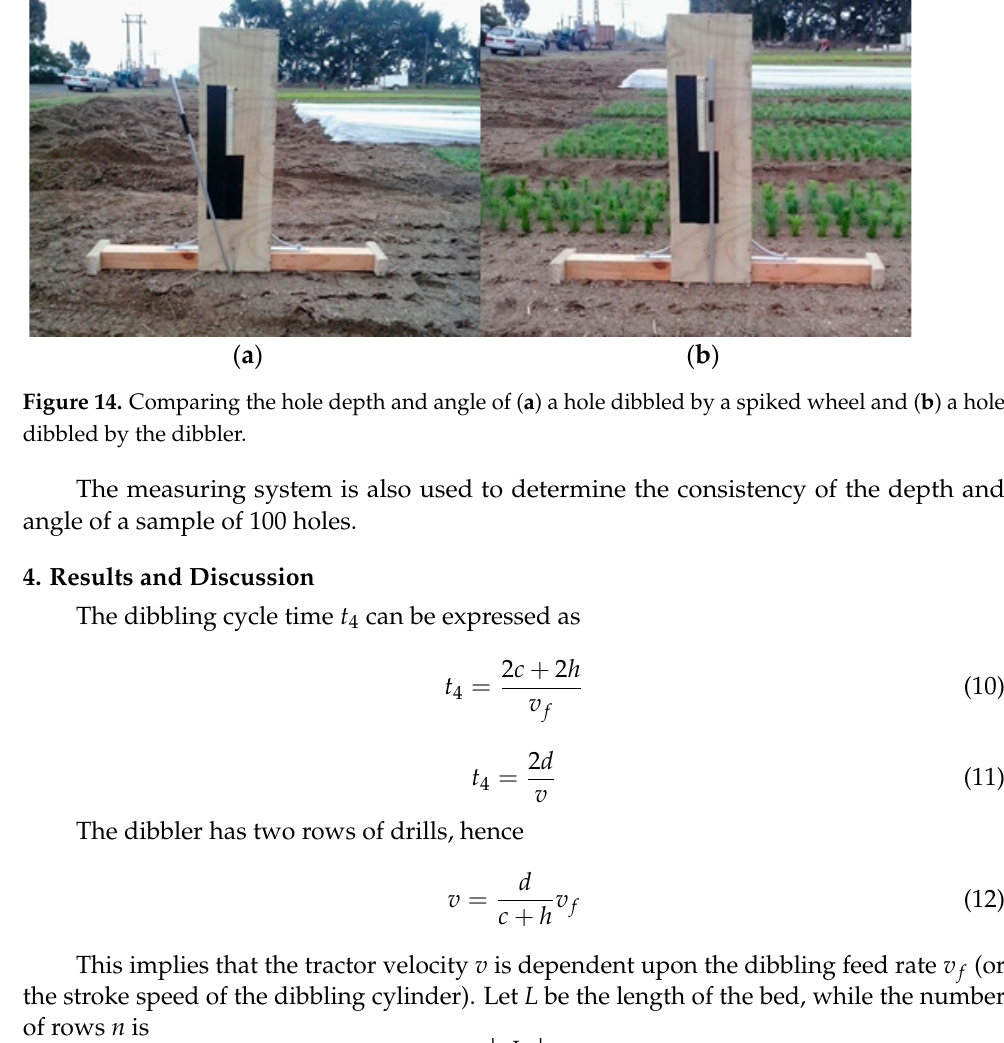
( b ) Figure 13. Dibbler field tests. ( a ) The dibbler and the tractor. ( b ) Planting bed with holes dibbled. The dibbler operation is as follows: 1. Check the hole depth and spacing. Adjust these hole parameters if necessary. 2.